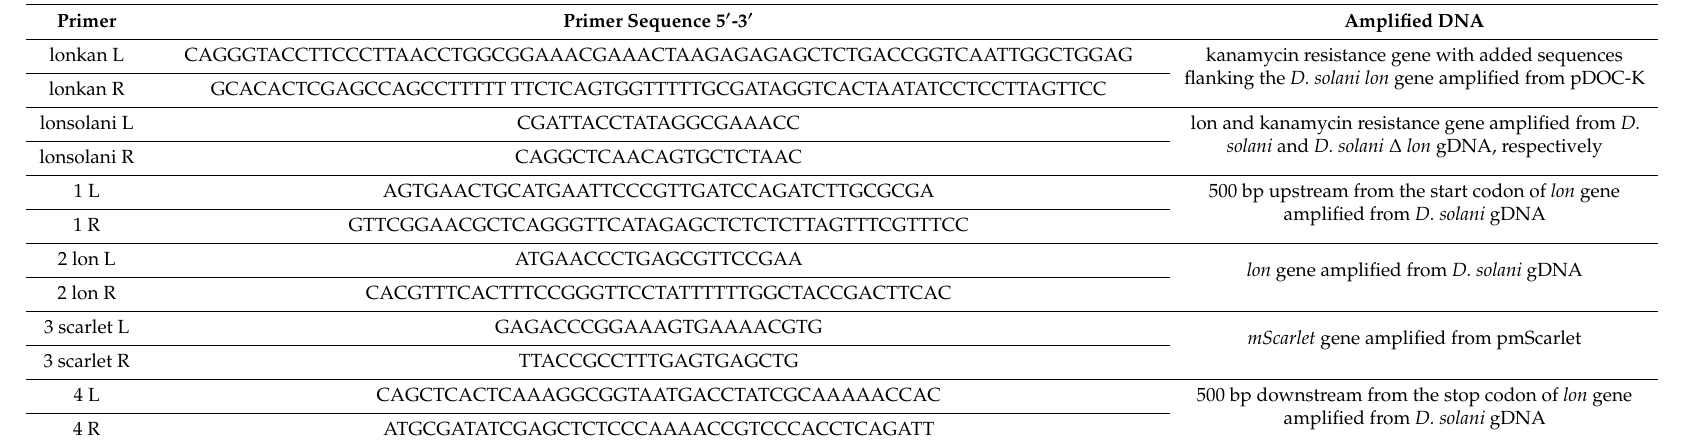
Table 3. List of primers and their